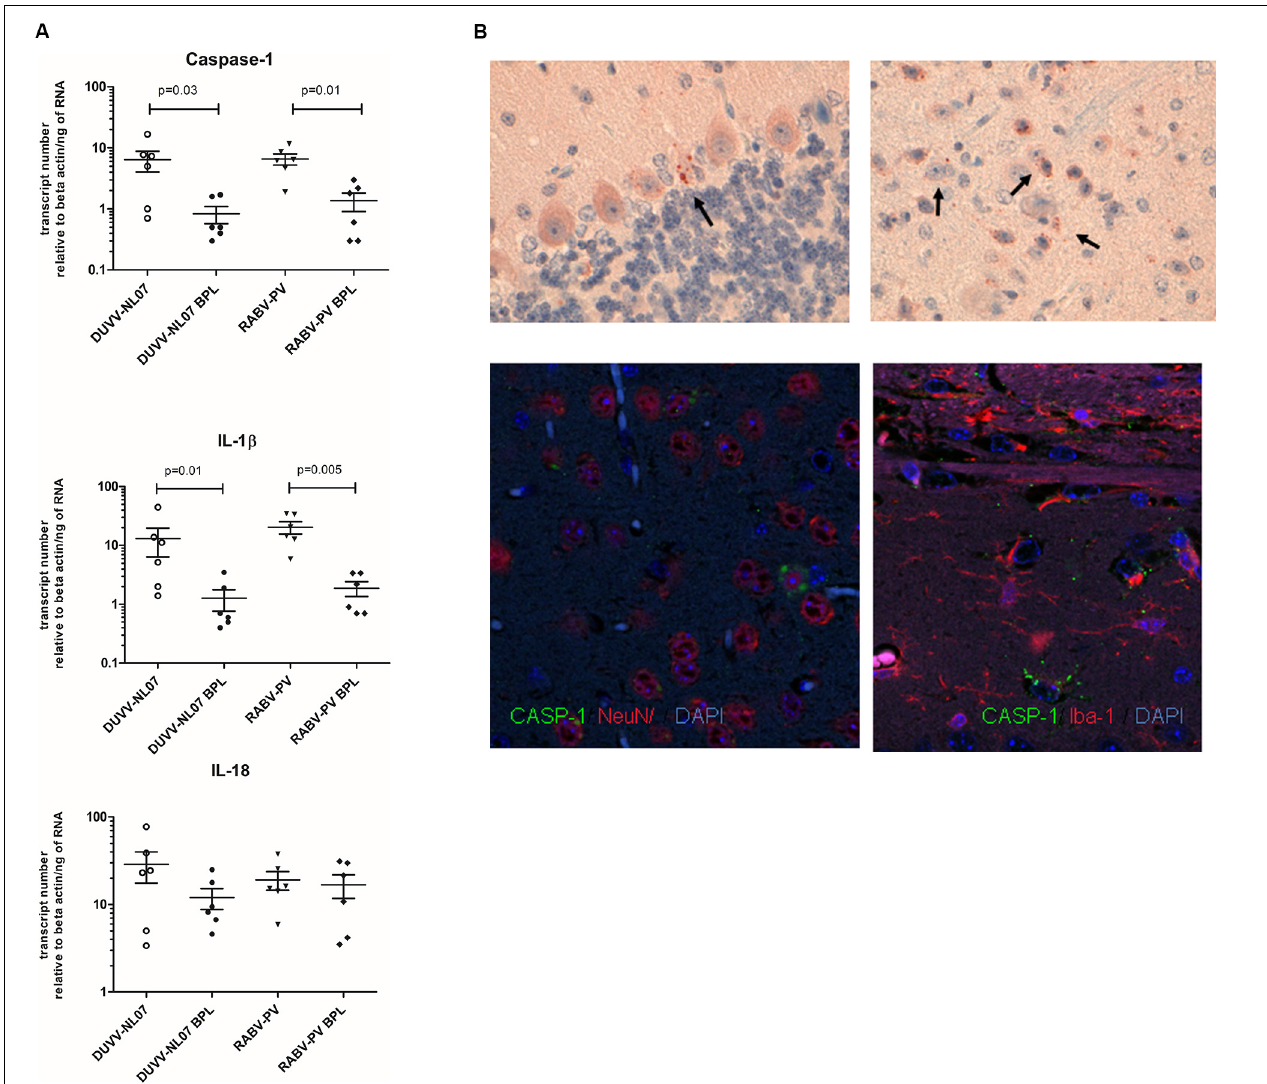
FIGURE 5 | Confirmation of pyroptotic pathway in mice infected with DUVV-NL07 and RABV-PV. (A) Genomics data were confirmed by qRT-PCR for key pyroptotic molecules. Means and standard error of the mean are depicted in the plots. Actual mean numbers are given in Table 4 for each gene. When differences are significant the p -value is given (Mann–Whitney non-parametric test). (B) Detection of p20 subunit of CASP-1 in mouse brains. CASP-1 was found in the mouse cerebellum (upper left panel) and cortex (upper right panel) of mice infected with DUVV-NL07. CASP-1 signal co-localized with NeuN (lower left panel) but not with IBA1 (lower right panel) indicating that neurons are the main producers of